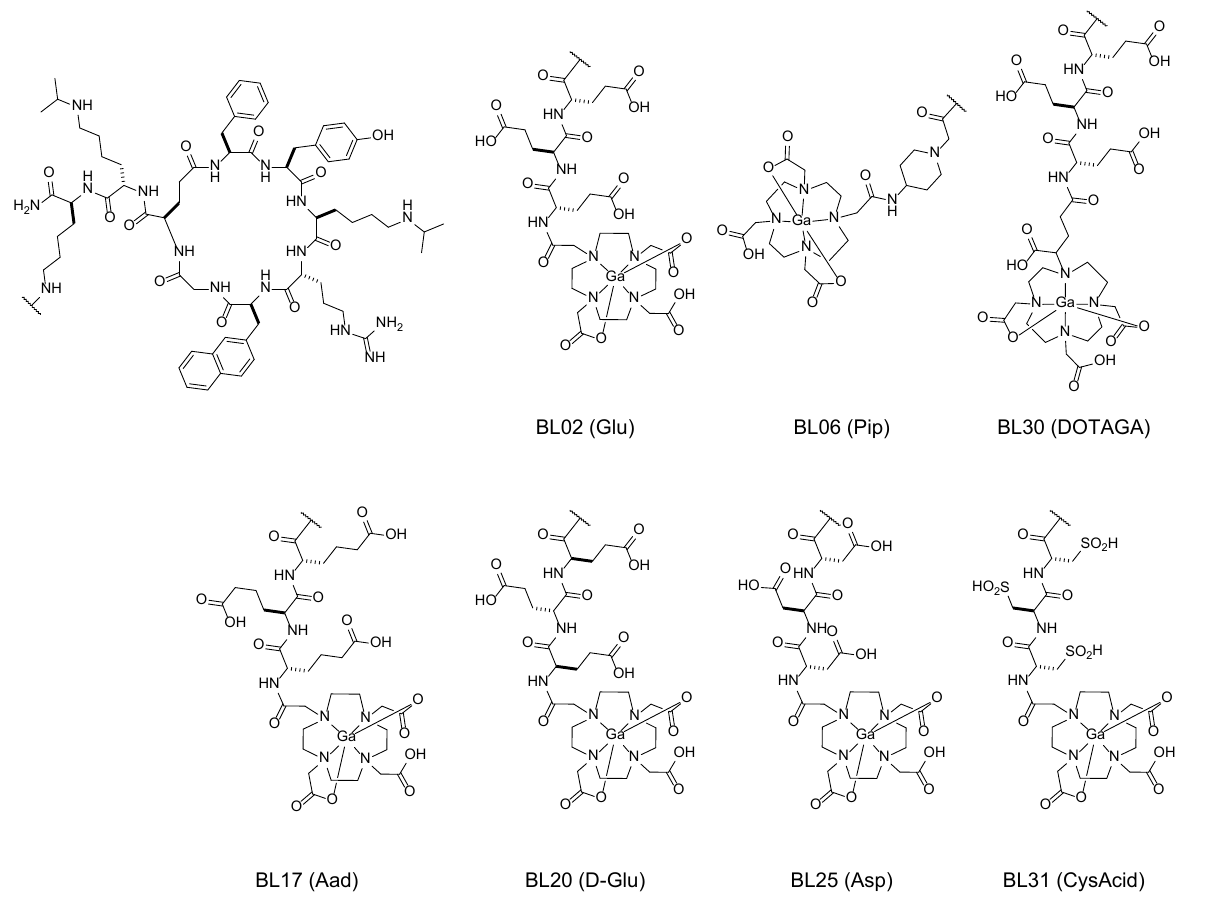
Figure 1. Representative chemical structures of the gallium-labeled BL02 (Glu); BL06 (Pip); BL17 (Aad); BL20 (D-Glu); BL25 (Asp); BL30 (DOTAGA); and BL31 (CysAcid).